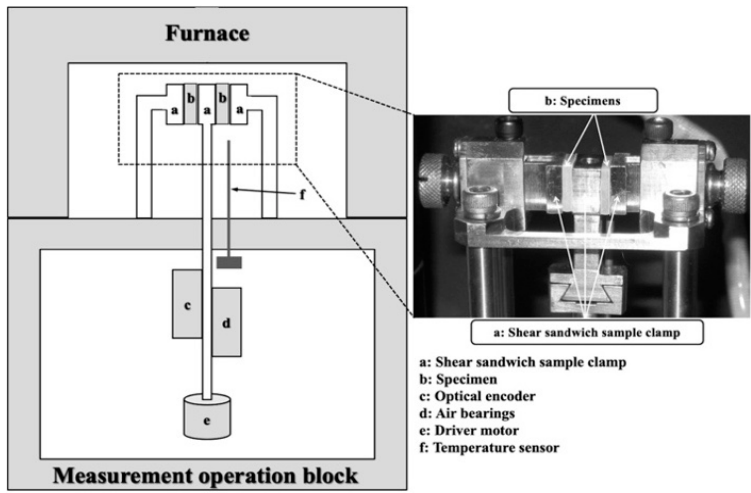
Figure 1. Block diagram of the automatic dynamic mechanical analyzer and shear sandwich sample clamp.